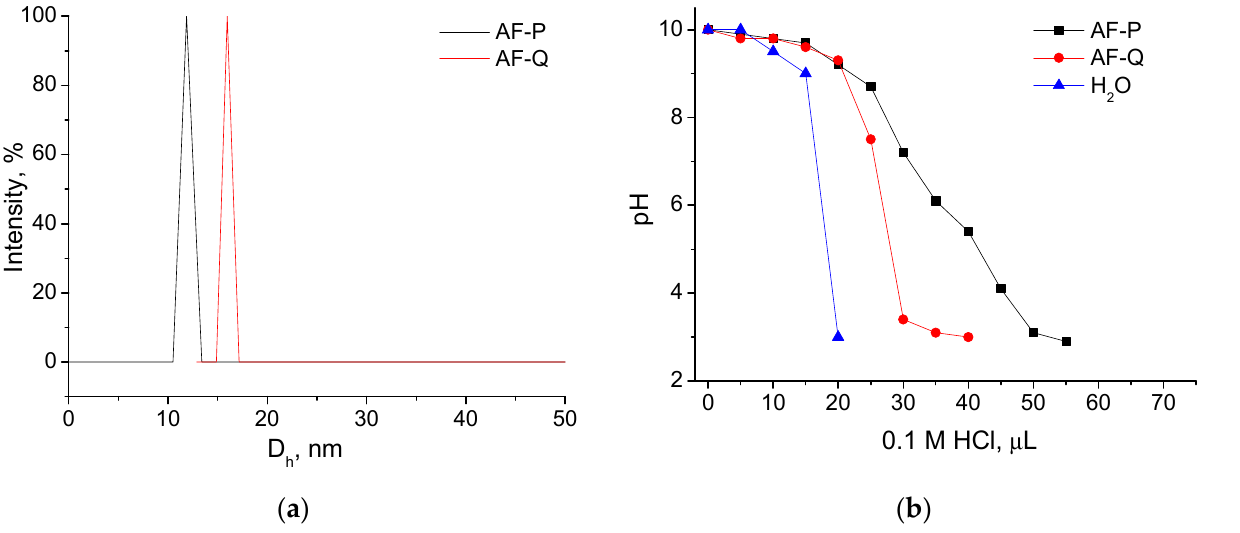
Figure 1. Size distribution curves from DLS of star-shaped PDMAEMA polymers in water at 25 °C